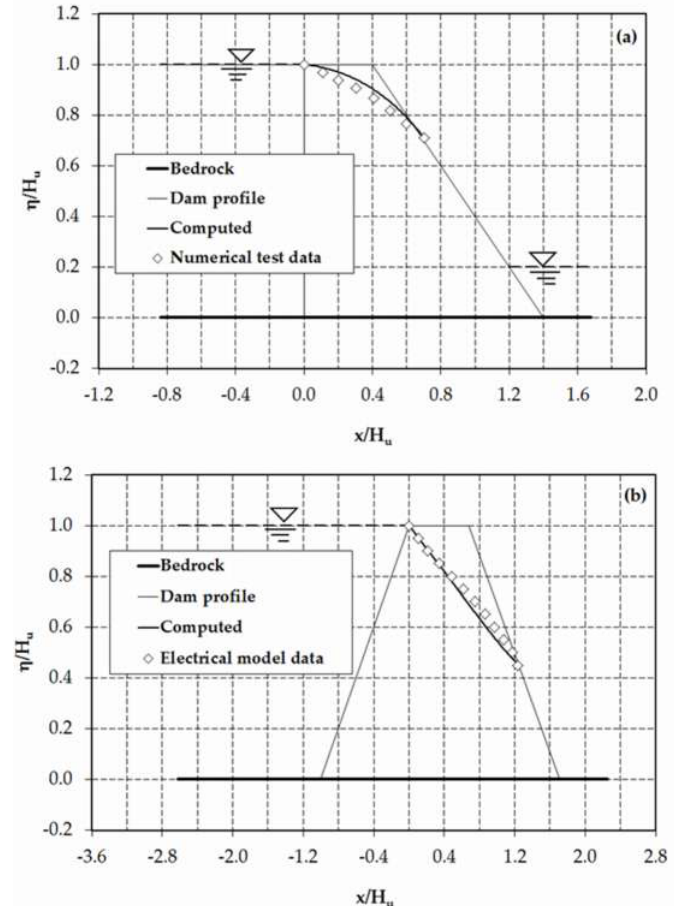
Figure 5. Unconfined seepage flows through homogeneous trapezoidal profile dams: ( a ) an asymmetrical dam with a vertical upstream face and a 45° downstream face slope ( 47.0/ u KHq ); and ( b ) a symmetrical dam with faces sloping at 45° ( 20.0/ u KHq ).